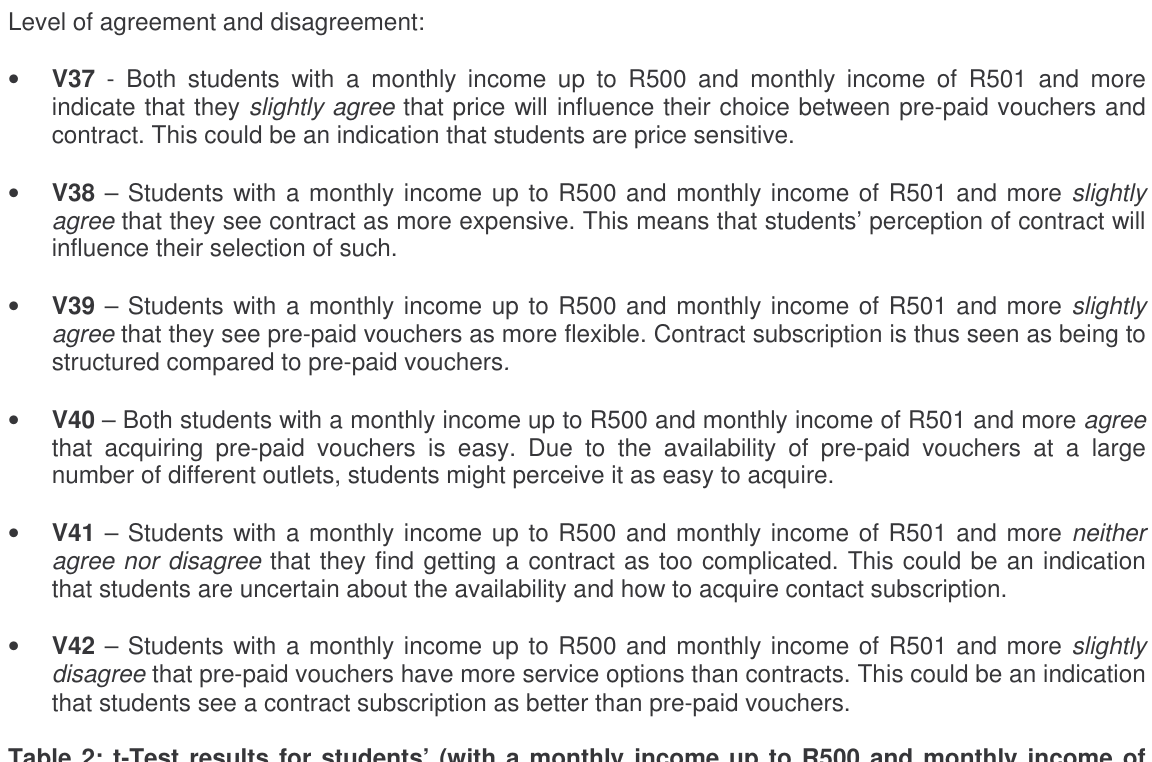
Table 2: t-Test results for students’ (with a monthly income up to R500 and monthly income of R501 and more) status value of cellular